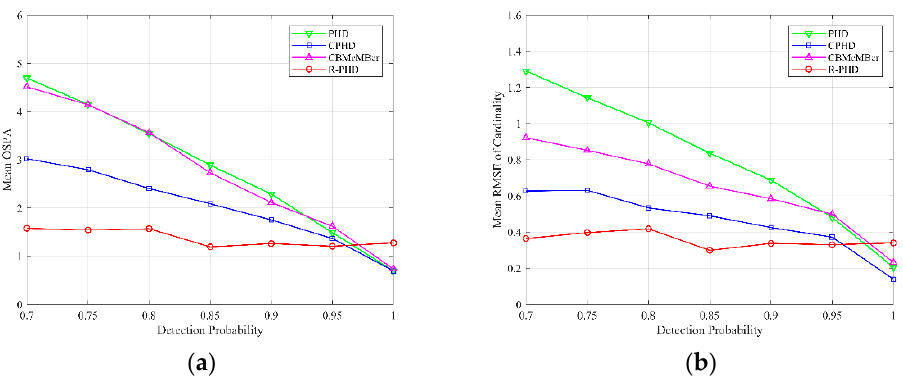
Figure 4. OSPA and cardinality performances of different methods with respect to different detection probabilities from p D = 0.7 to p D = 1 ( λ = 10): ( a ) mean OSPA; ( b ) mean RMSE of cardinality.